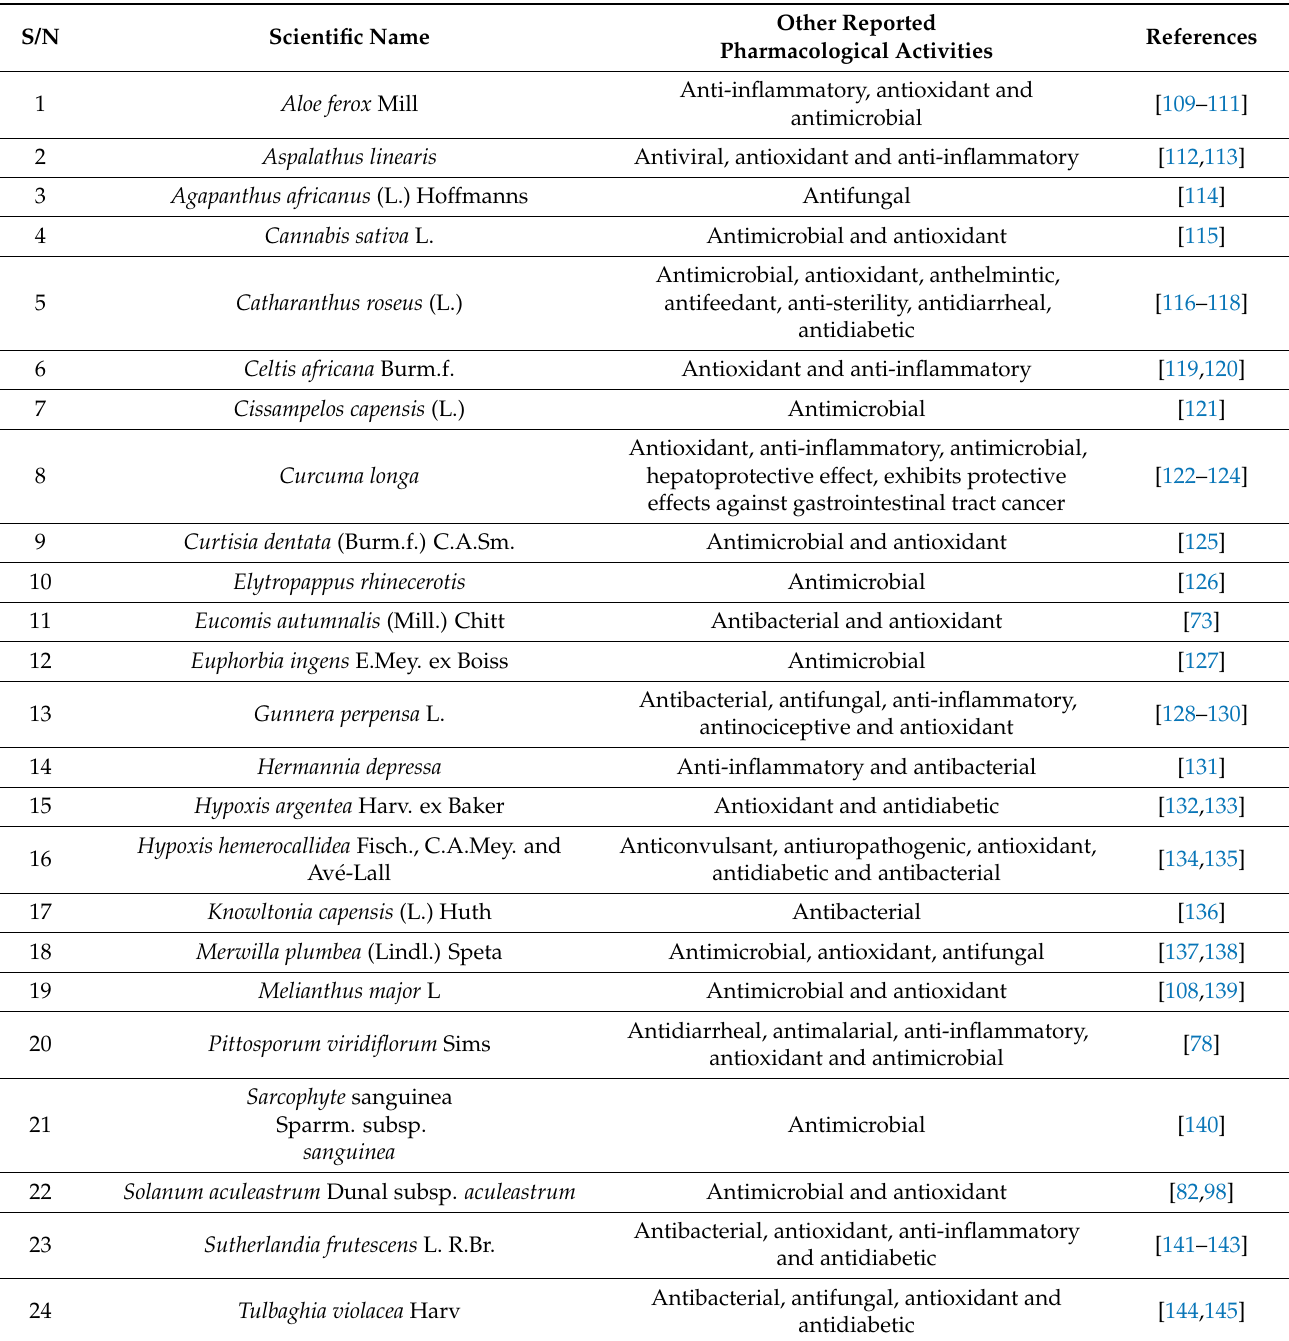
Table 4. Pharmacological activities of anticancer plant species used in Eastern